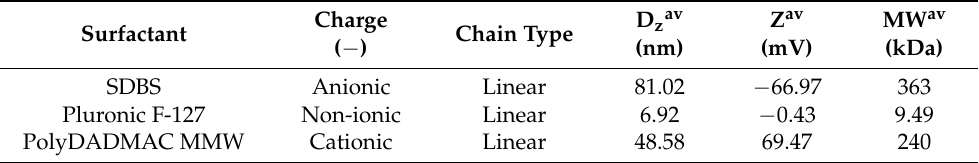
Table 1. Summary of surfactants characterization